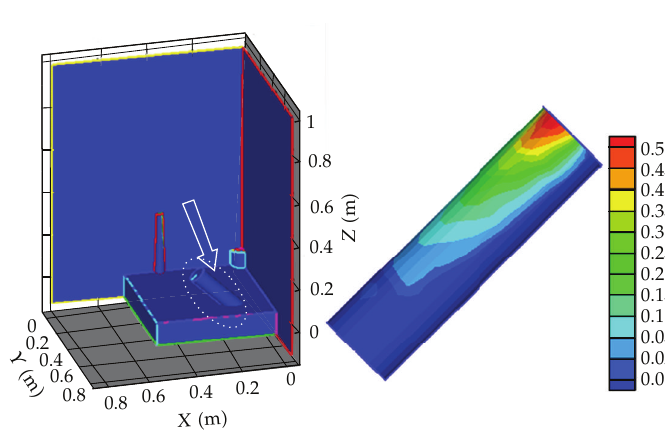
Figure 8: Sputtering depth for surface 2 (cid:2) μ m/200h (cid:3)